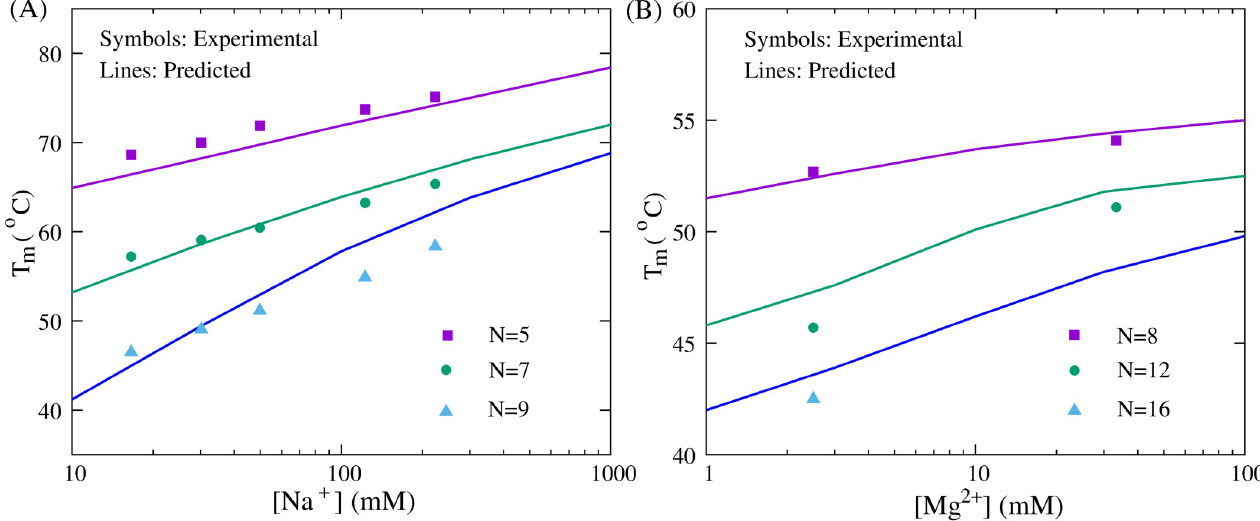
Fig 8. The comparisons of stability between predictions (lines) and experiments (symbols) for ssDNAs in monovalent/divalent ion solutions. (A) The melting temperatures ( T m ’s) as functions of [Na + ] for the DNA hairpins (GCGC(T) N GCGC) with different loop lengths: 5, 7, and 9 from top to bottom, respectively. Symbols: experimental data [90]. Lines: predictions from the present model. (B) The melting temperatures ( T m ’s) as functions of [Mg 2+ ] for the DNA hairpins (CGGATAA(T) N TTATCCG) with different loop lengths: 8, 12, and 16 from top to bottom, respectively. Symbols: experimental data at 2.5mM or 33mM [Mg 2+ ] with 10mM Tris-HCl buffer [96]. Lines: predictions from the present model at extensive [Mg 2+ ]’s without Na + .